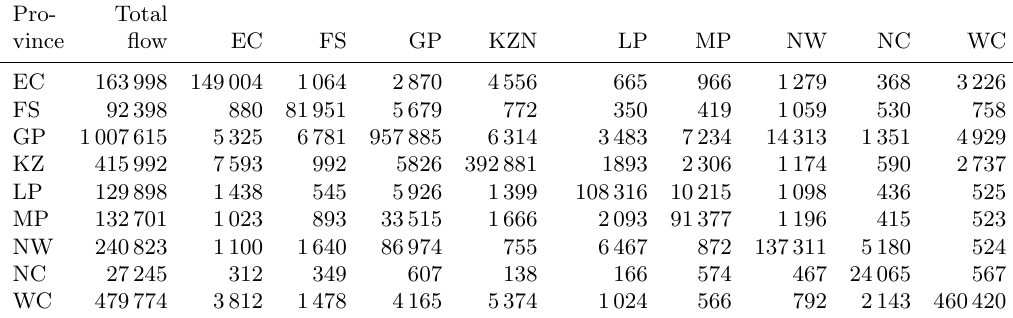
Table 2: Commuter flow within and between the current nine provinces. The following abbrevi- ations are used: EC = Eastern Cape, FS = Free State, GP = Gauteng, KZN = KwaZulu-Natal, LP = Limpopo, MP = Mpumalanga, NW = North West, NC = Northern Cape and WC = Western Cape. Total flow value within provinces: 2 403 210 (89.32%). Total flow value between provinces: 287 234